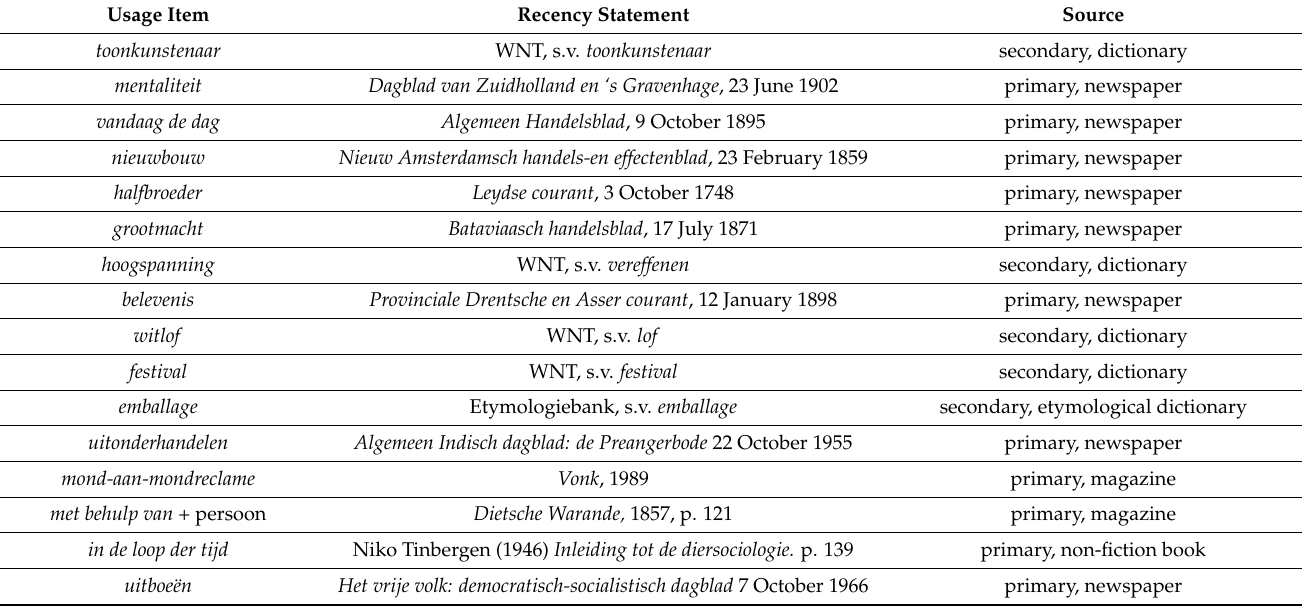
Table A1. Lexical usage items with source for usage dating and type of source.